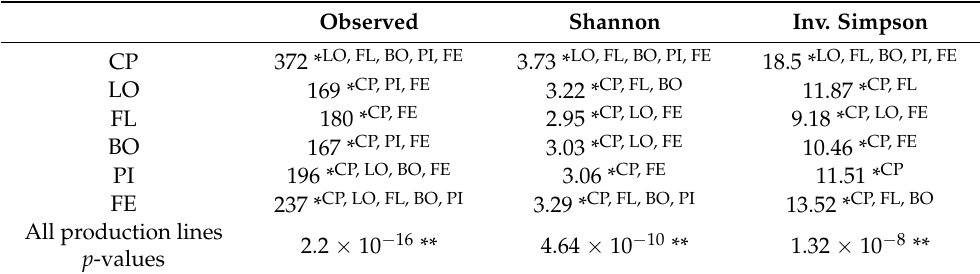
Table 4. Comparison of alpha-diversity indices of the microbiota samples from the six production